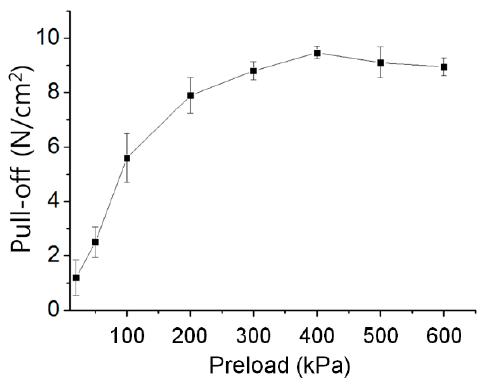
Figure 3. Measurement data of the pull-off strength of fabricated dry adhesives as a function of preload.